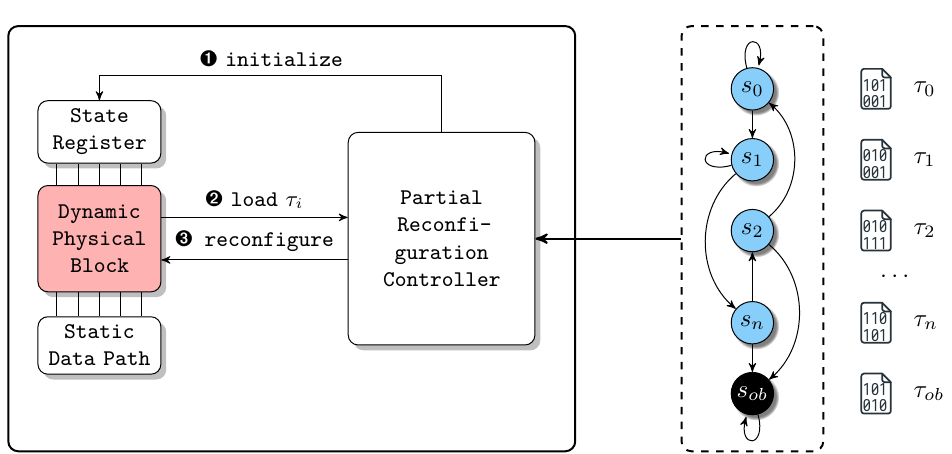
Figure 12: Hardware Nanomites system overview. Before using the first partial design τ 0 , the state register is initialized to load it. After obtaining a request to load the next partial design τ i , the partial reconfiguration controller then loads the requested design and reconfigures the dynamic physical block. The partial design interacts with the static data path and state register to perform calculations and afterwards requests loading of the next design. Note that state s ob (marked in black) represents a bogus